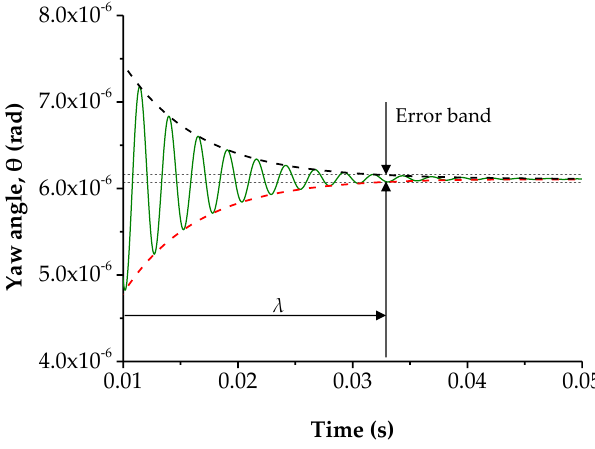
Figure 12. Zoomed yaw angle graph: settling time ( λ ) and error band.